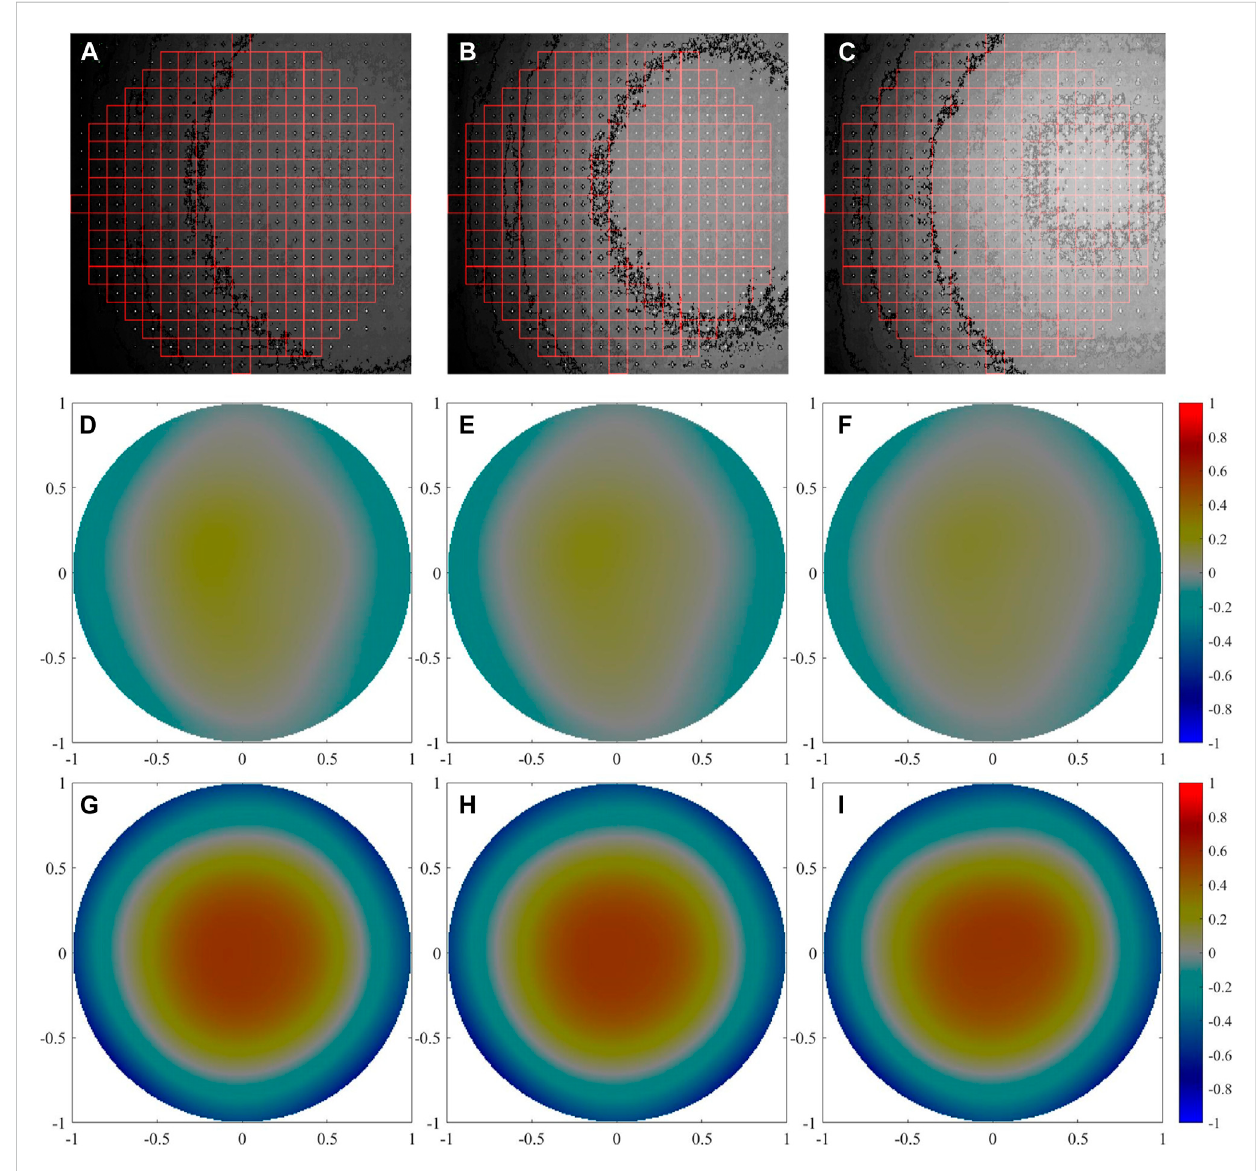
FIGURE 9 (A – C) thetotalintensity calculatedbyp-SHWFS underthethreenoiselevels,thewavefrontmeasurement resultsbetween traditionalmethod (D – F) and p-SHWFS (G – I) under different noise